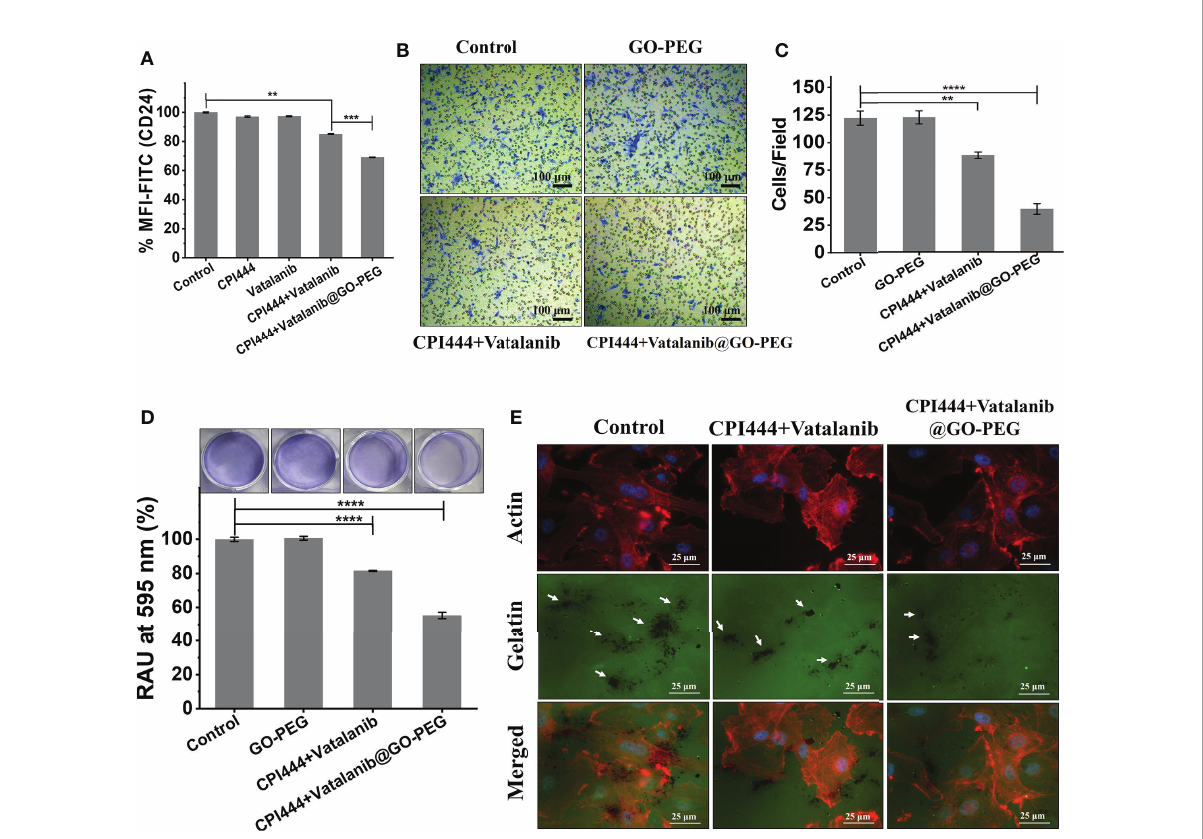
FIGURE 8 CPI444 and vatalanib@GO-PEG hindered the cellular migration and invasive behavior of GBM U87 cells. (A) CD24 expression levels in GBM U87, quantitated by FACS analysis after treatment with CPI444 and vatalanib-loaded GO-PEG and other combinations. (B, C) Boyden chamber analysis (Transwell migration assay) was performed for cell migration properties. The combination of nanoconjugate CPI444 and vatalanib- treated cells shows smaller numbers of migrated cells compared to control. ( D) The adhesive property of GBM cells was signi fi cantly reduced after the treatment with the GO-PEG conjugated combination of CPI444 and vatalanib. RAU%, Relative absorbance units in percentage. ( E) Invadopodia causing dark gelatin degradation patches (indicated by white arrows) were detected by the gelatin degradation assay under different treatment conditions. **** p < 0.0001, *** p < 0.001, and ** p <